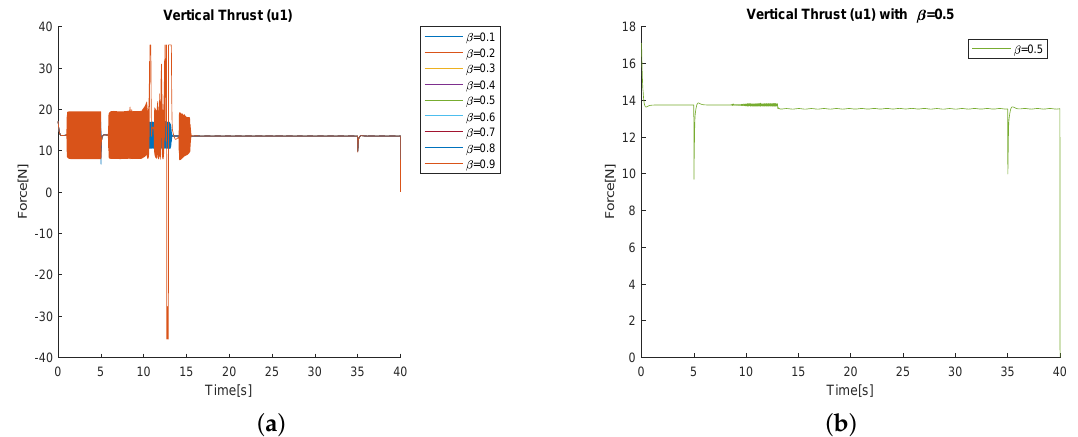
Figure 12. ( a ) Vertical Thrust with distinct β ’s; ( b ) Vertical Thrust with β = 0.5.